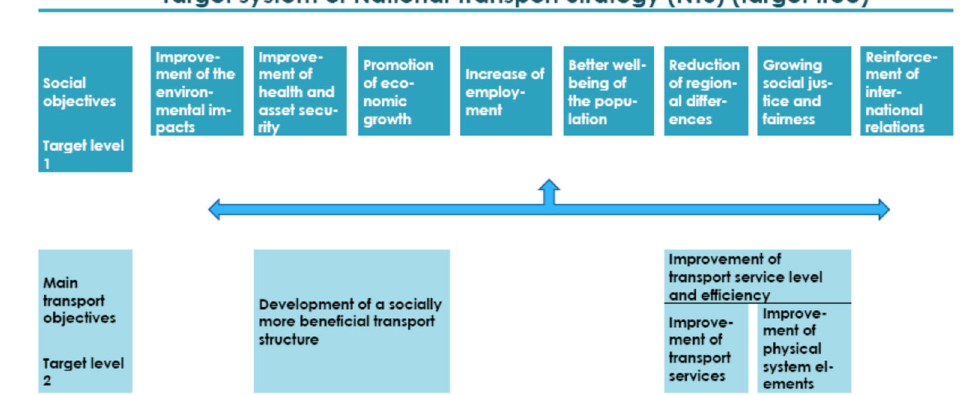
Fig. 5 Target system of the National Transport Strategy [1] pp.